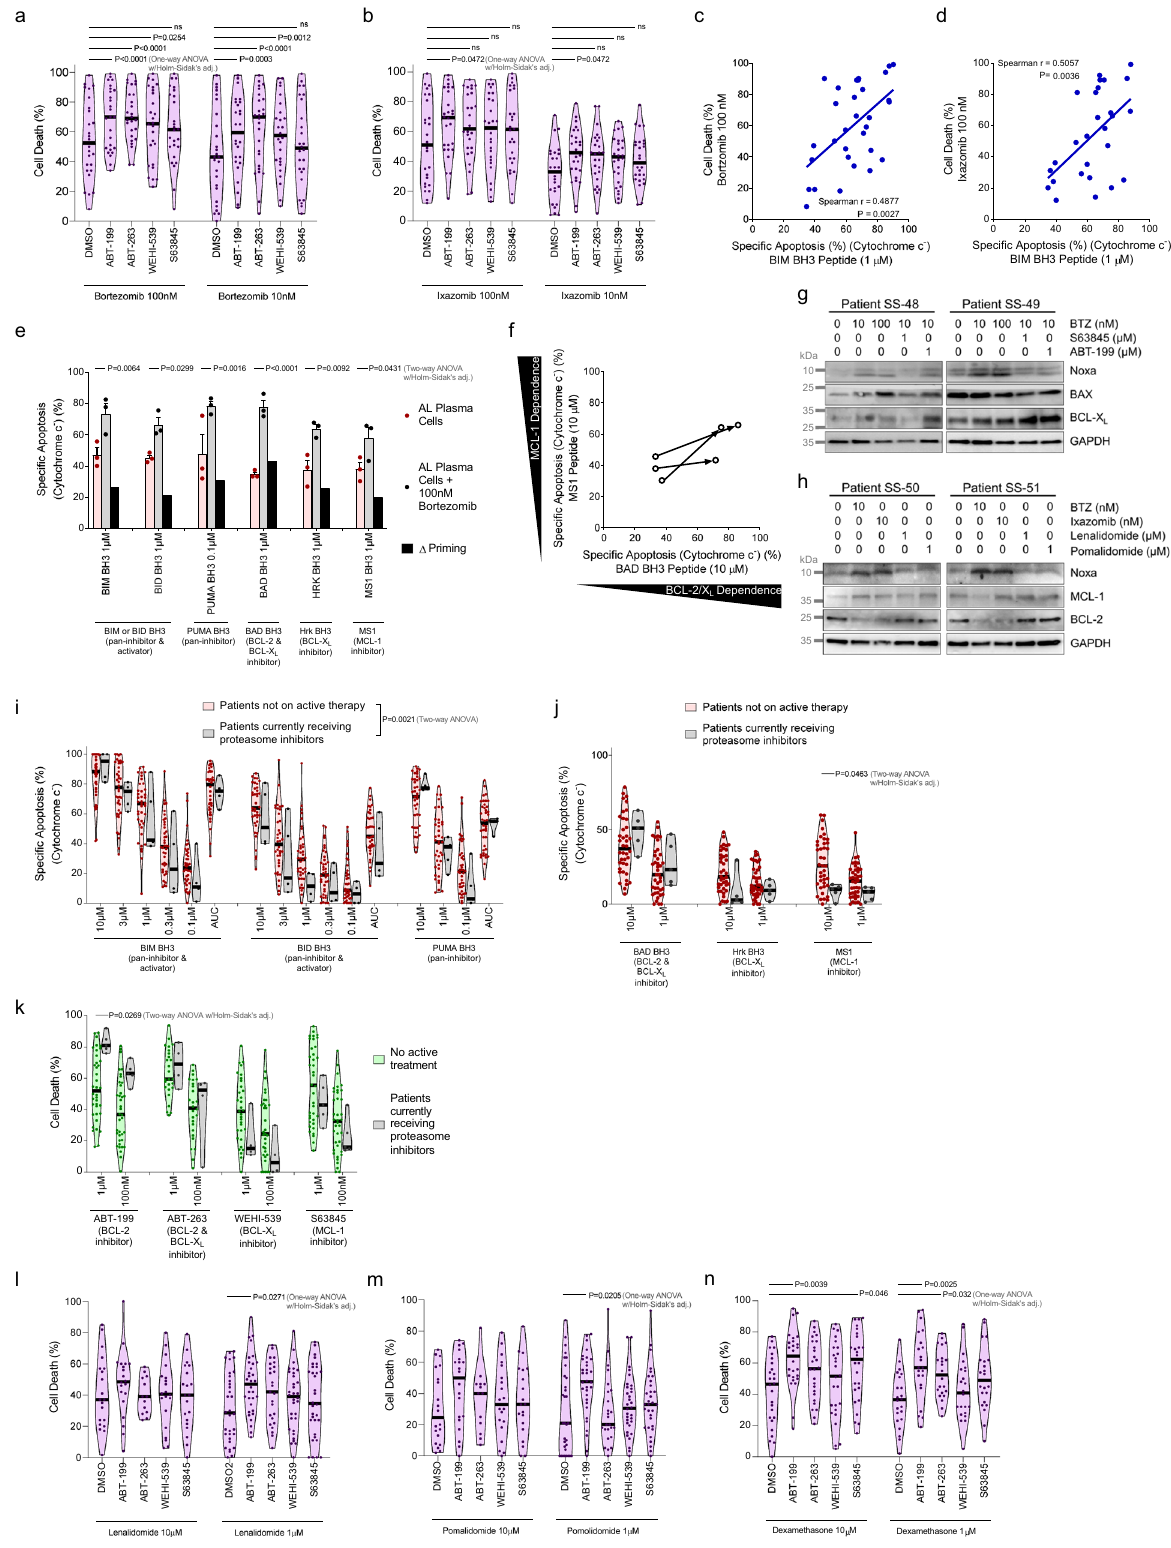
dependence on BCL-2 while the MM cell line did not (Fig. 4b). Borte- zomib treatment increased apoptotic priming in both cell lines and strengthened existing dependencies as measured by BH3 pro fi ling (Fig. 4c, d). Consistent with these data, we found that ALMC-1 cells were sensitive to small molecule inhibitors of BCL-2 or MCL-1 while the ALMC-2 cells were sensitive only to MCL-1 inhibitors (Fig. 4e).